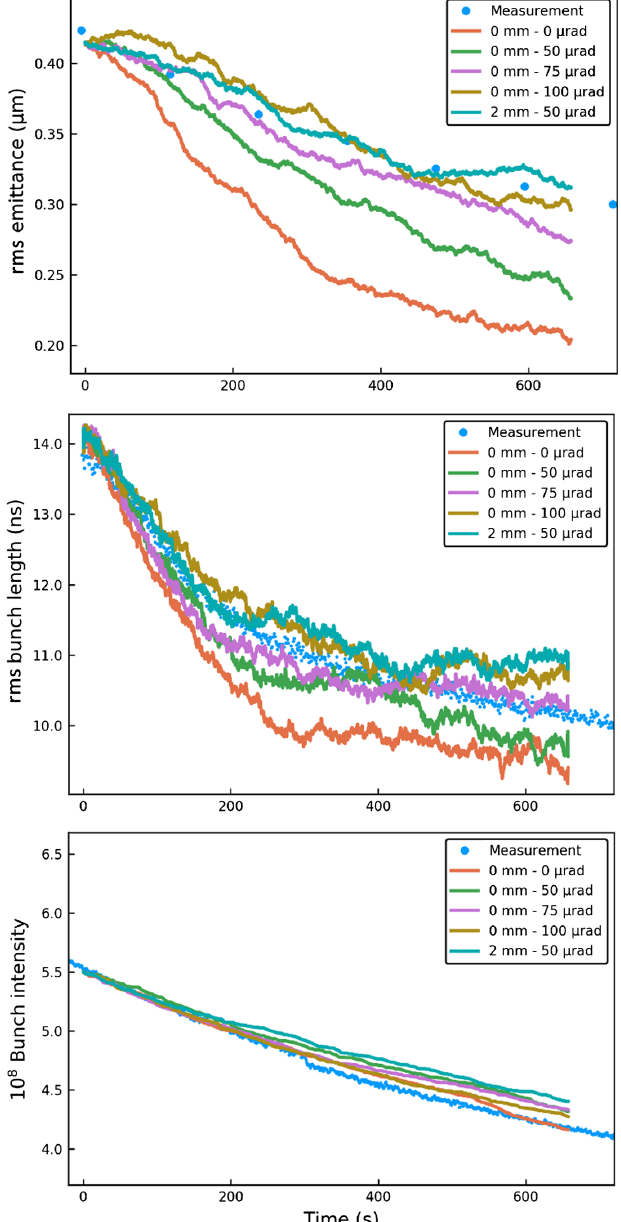
FIG. 9. Measurement and simulation results of the cooling